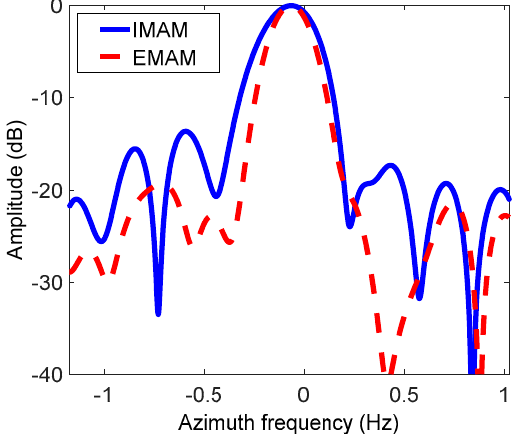
Figure 12. The azimuth impulse responses of the chosen strong scatterer based on the IMAM method and the EMAM method.